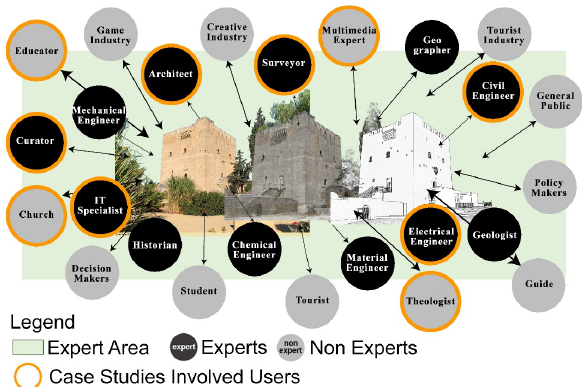
Figure 1. The diagram illustrates the multidisciplinary community of governmental organisations,